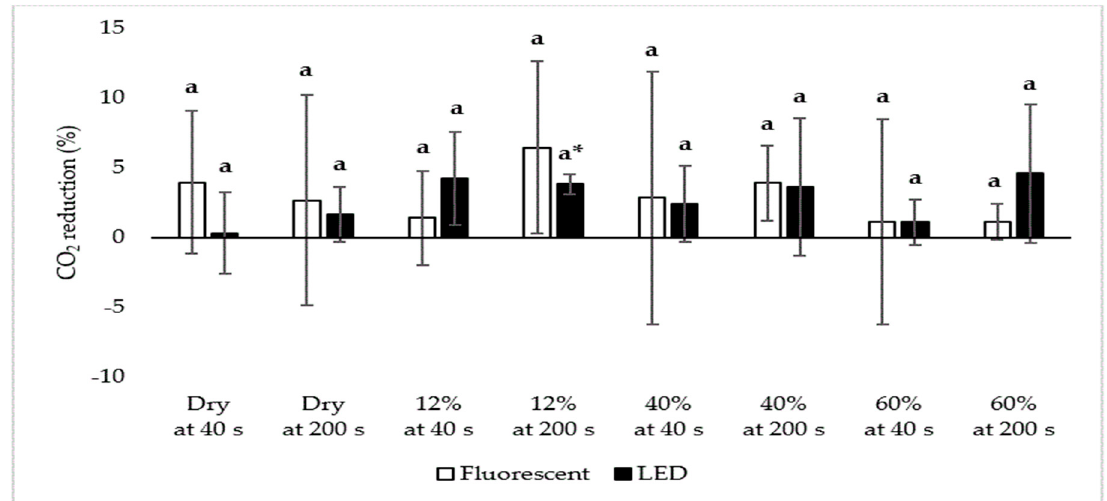
Figure 10. CO 2 mitigation under different light intensity, treatment time, and relative humidity in photocatalysis. Superscript (*) signifies a statistical difference compared to the control ( p < 0.05), and the character (a) signifies there is no statistical difference under the two different treatment times ( p > 0.05). Error bars singify ± standard deviation.